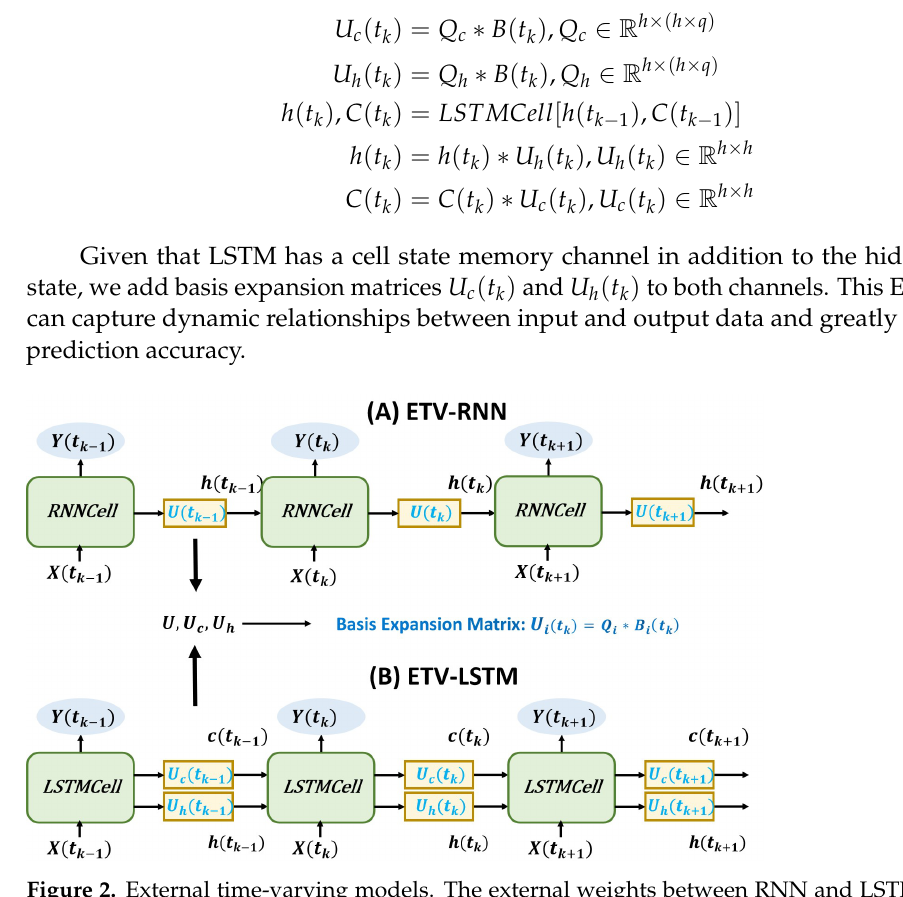
Figure 2. External time-varying models. The external weights between RNN and LSTM cells are updated using the basis expansion